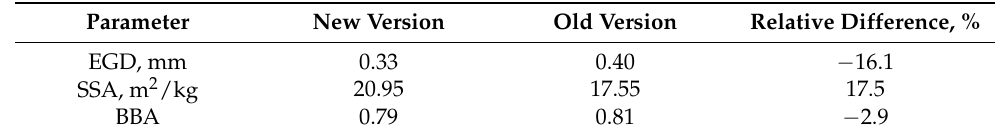
Figure 8. ( A ) The differences in the retrieved values of EGD, SSA and BBA (in percent) between two versions of the code; ( B ) The correlation between new and old values of the retrieved EGD. The coefficient of correlation is 0.9221 and the linear correlation equation can be presented as follows: y = 0.74x + 0.04. Table 8. The average values of the retrieved parameters according to new and old versions of the algorithm.